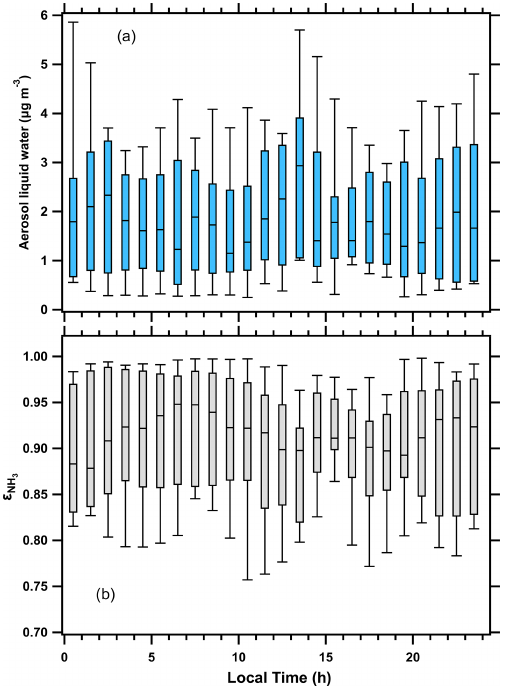
Figure 2. Box plots of (a) aerosol liquid water and (b) ε NH = NH + NH + ( ε NH (aq))) during the OWLETS-2 3 (g)/(NH 3 (g) 4 3 study. The statistics shown are the median, quartiles, and 10th and 90th